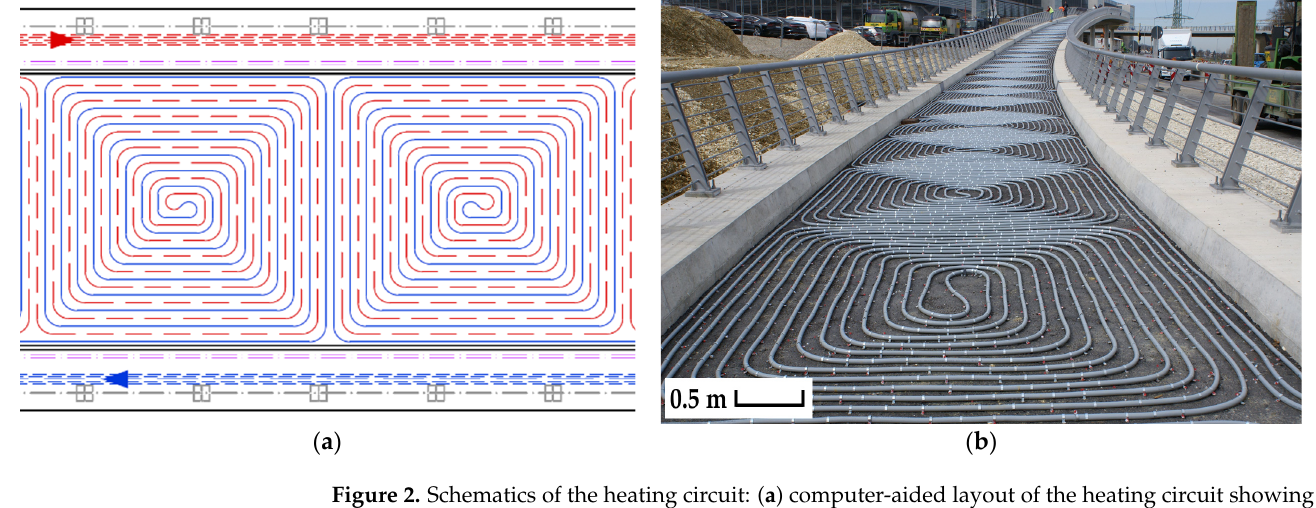
Figure 2. Schematics of the heating circuit: ( a ) computer-aided layout of the heating circuit showing pipes containing warm fluid (red) from the heat pump and cold fluid (blue) from the road surface; ( b ) installation pattern of the heating circuit on the intermediate layer of exit West ramp.